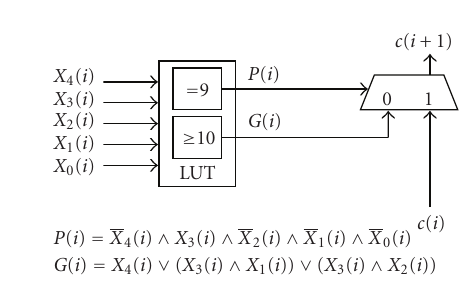
Figure 2: Fast carry computation.